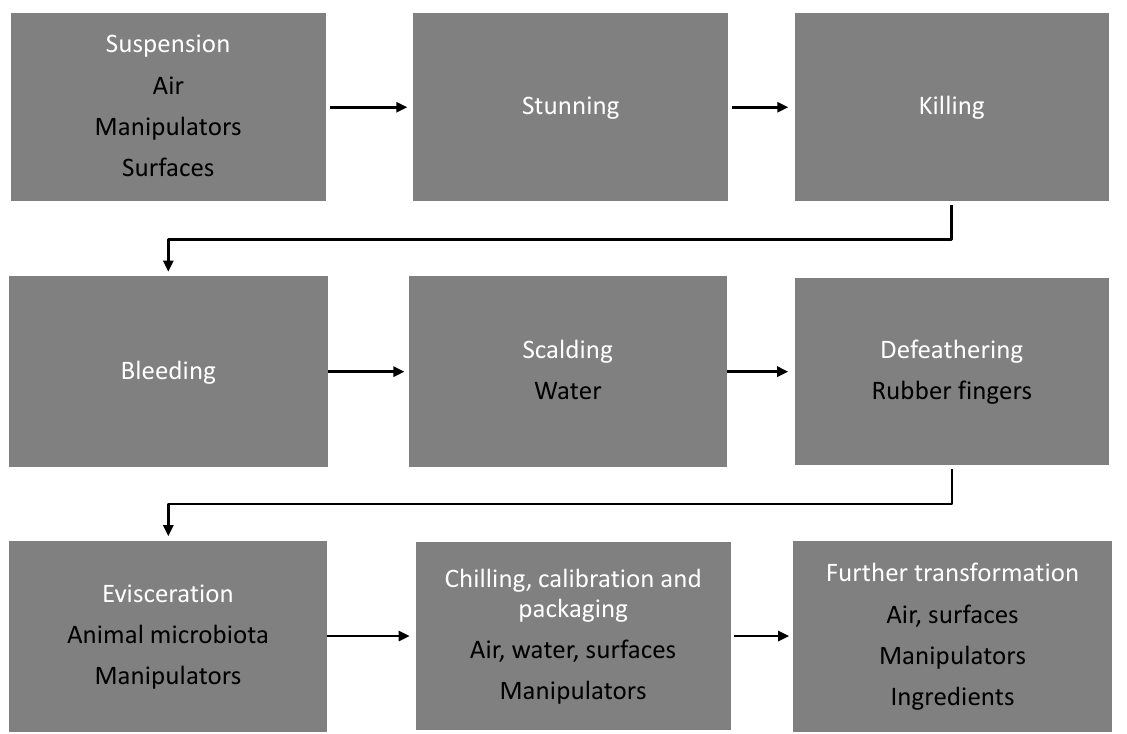
Figure 1. Scheme representing the successive steps from poultry slaughtering to meat production and the associated contamination routes. After transport, the birds are suspended from the conveyor and then stunned and killed. After bleeding, the birds are scalded in hot water at a temperature ranging from 50 to 60 ◦ C to loosen the feathers. Subsequently, the feathers are mechanically abraded from the scalded birds. In large-scale slaughterhouses, feathers are removed using rotating rubber fingers and then the carcasses receive a spray wash prior to evisceration. Evisceration can be carried out by mechanical aspiration or manually after the carcasses have been cut open. At this stage, the gizzard, heart, and liver are also retrieved. Next, the carcasses are chilled, either by immersion in cold water or by air chilling. Subsequent transformation steps include cutting, deboning, grinding, and the use of various treatments for meat product storage such as marinating or addition of different ingredients (salt, spices) in processed products such as sausages.